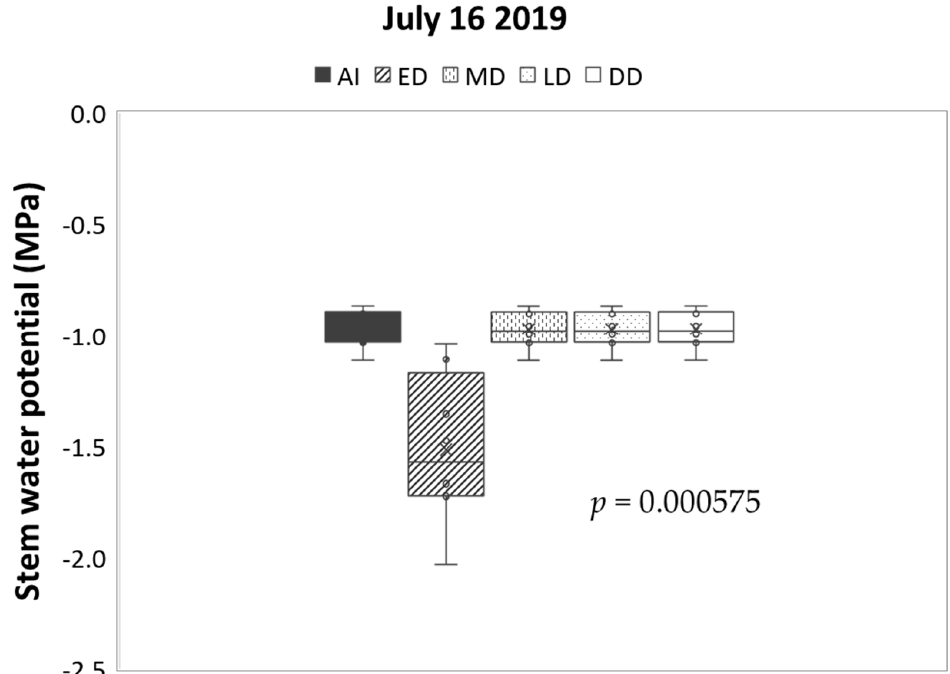
Figure 5. Stem water potential in Ambrosia TM trees in early summer. The data were collected on July 16 2019 (73 days AFB), with eight replicates. The statistical significance between irrigation treatments was analyzed using an ANOVA single-factor model ( p ≤ 0.05). The box shows the minimum, first-quartile, median, third-quartile, and maximum values. The bars with error bars are means ± standard errors. AI = adequate irrigation; ED = early-summer deficit irrigation (DI); MD = middle-summer DI; LD = late-summer DI; DD = double-period DI.